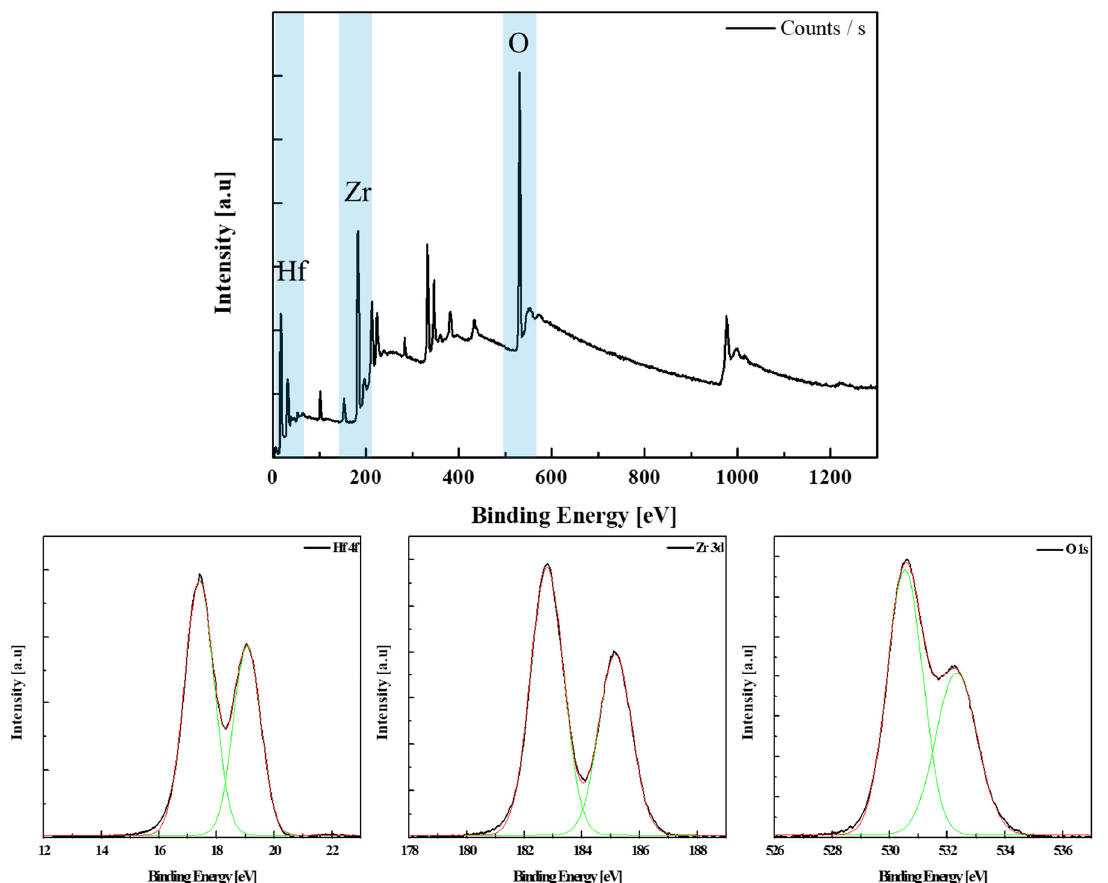
Figure 6. XPS spectra of the (20,20)*3 specimen. The nanolaminate and crystallinity of the HZO layer were confirmed using the TEM image in Figure 5, and the crystal phase of each sample was confirmed using HR ‐ XRD analysis. The HR ‐ XRD spectra of the deposited thin film demonstrate the effect of the seed layer and heat ‐ treatment conditions on the crystallinity of the sample (Figure 7). The M phase, with corresponding peaks at 28.5° and 31.7°, exhibits non ‐ ferroelectric properties. In addition, a peak at 30.5° confirms the presence of the O phase, which is known to exhibit ferroelectric properties.